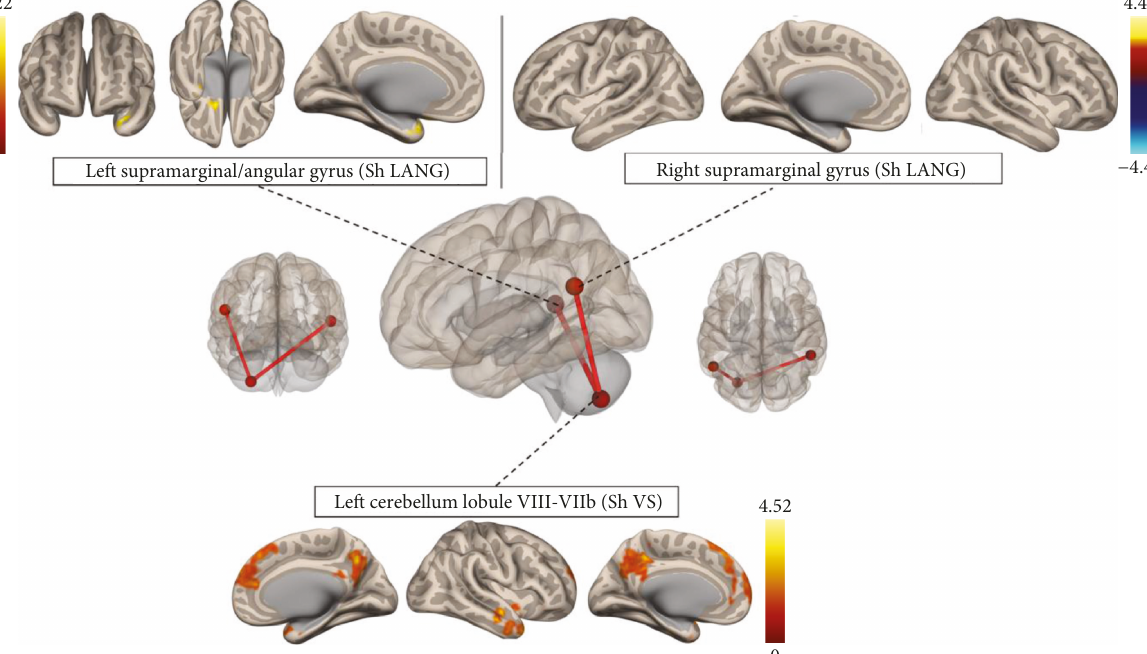
Figure 7: Most representative measure of the Speed component explained by resting state functional connectivity. ROI-to-ROI analyses reveal a positive correlation in the cerebellum lobule VIII-VIIb and bilateral superior temporal cortex connections. Seed-to-voxel results, thresholded (FDR corrected), are shown for each of the 3 nodes. Unthresholded pattern activation is shown in Figure S5 supplementary materials. All voxels with signi fi cant connectivity changes are shown in the fi gure and listed in Table S4, Supplementary materials. Note: H-O: Harvard-Oxford; Sh LANG: Shirer language; Sh VS: Shirer